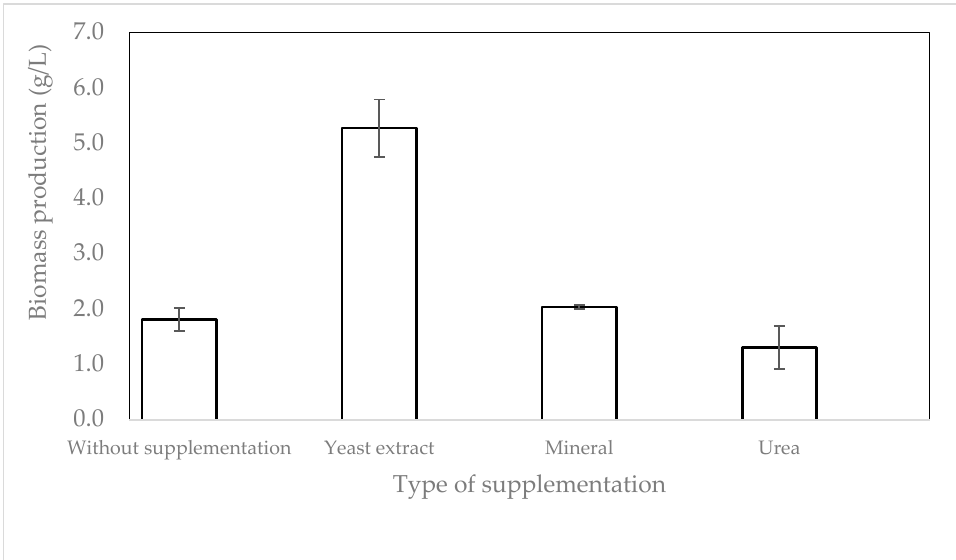
Figure 2. Biomass production from tempeh residual boiling water supplemented with different nu ‐ trients.